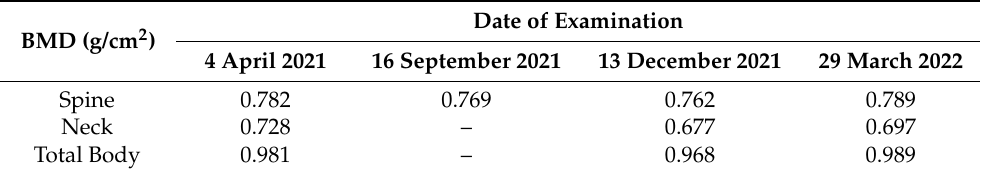
Table 2. Results of bone densitometry